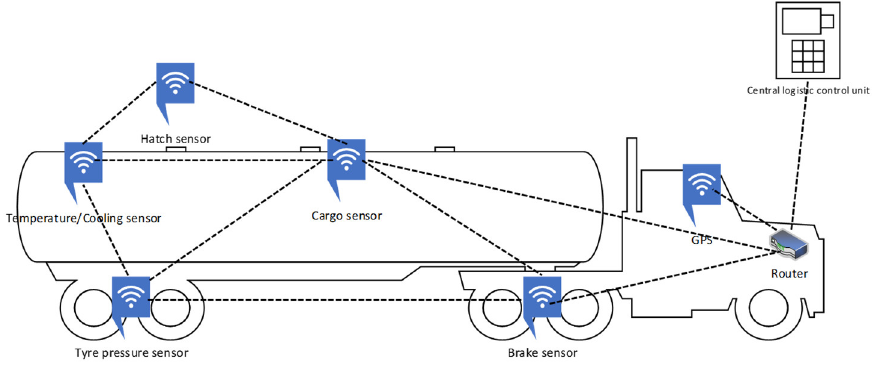
Figure 1. IoT-Powered food haulage truck.